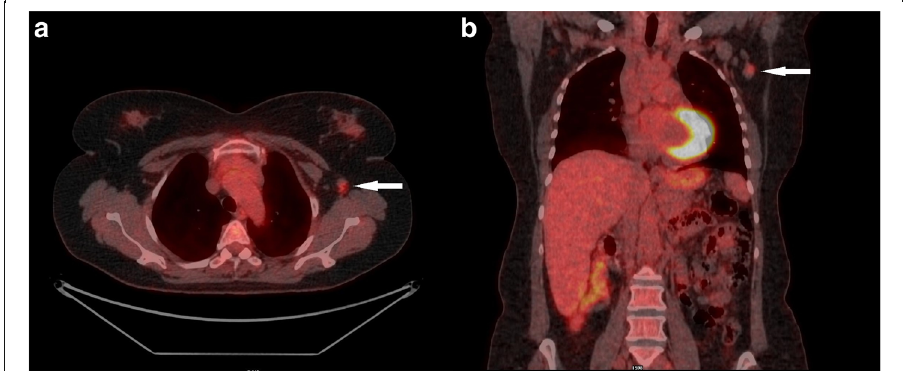
Fig. 2 a Transverse and b coronal image of 18 F-FDG PET/CT in patient with IDC and left axillary lymph node metastasis. PET/CT identified aggressive early breast HR positive IDC with high score of HER2 expression (not showed). In this case PET/CT served as a supplementary staging procedure. PET/CT shows left axillary lymph node metastasis (SUVmax=5.7). Classification after PET/CT was T1bN1M0. With the permission of the Third Department of Nuclear Medicine, Medical School, Aristotle University of Thessaloniki, Papageorgiou General Hospital, Thessaloniki, Greece. FDG: Fluorodeoxyglucose, IDC: Invasive ductal carcinoma, HR: Hormone receptor, HER2: Human epidermal growth factor receptor